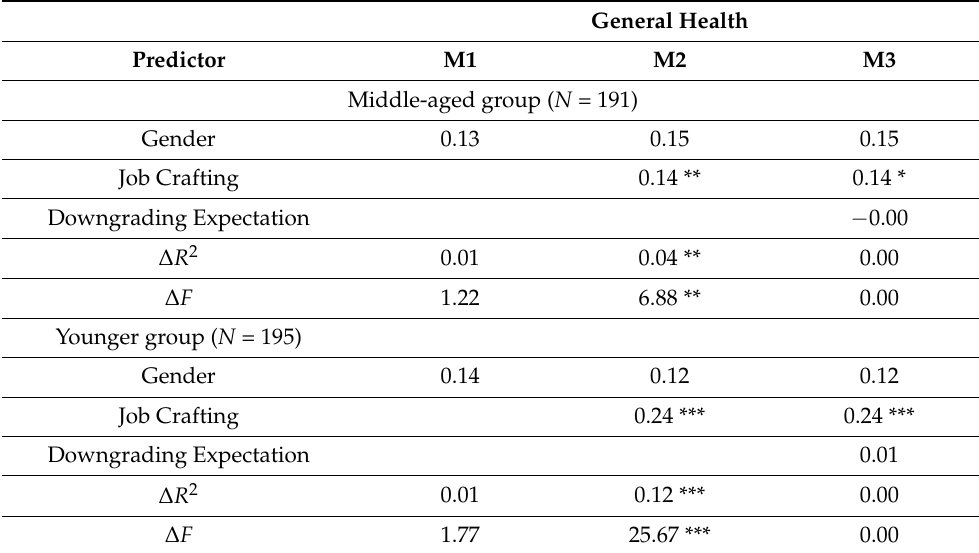
Table 8. Results from hierarchical regression analyses of Downgrading Expectation predicting general health.